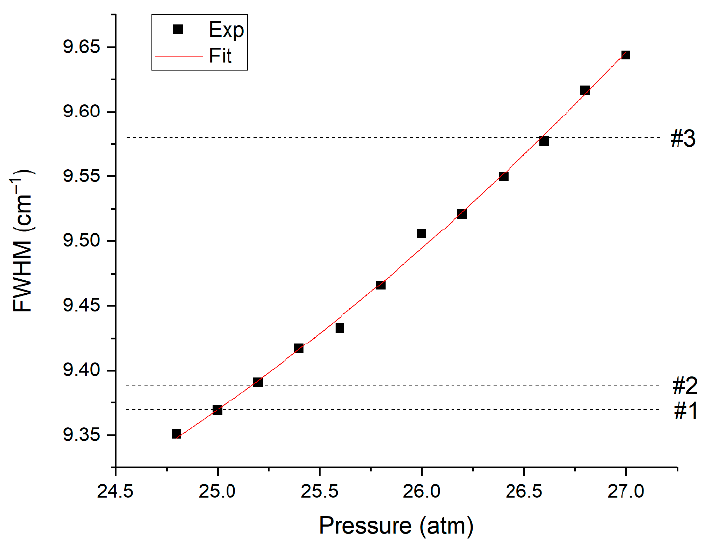
Figure 8. Half-width of the methane line at 1793 cm –1 in pure methane at various pressures and in analyzed samples at 25 atm.